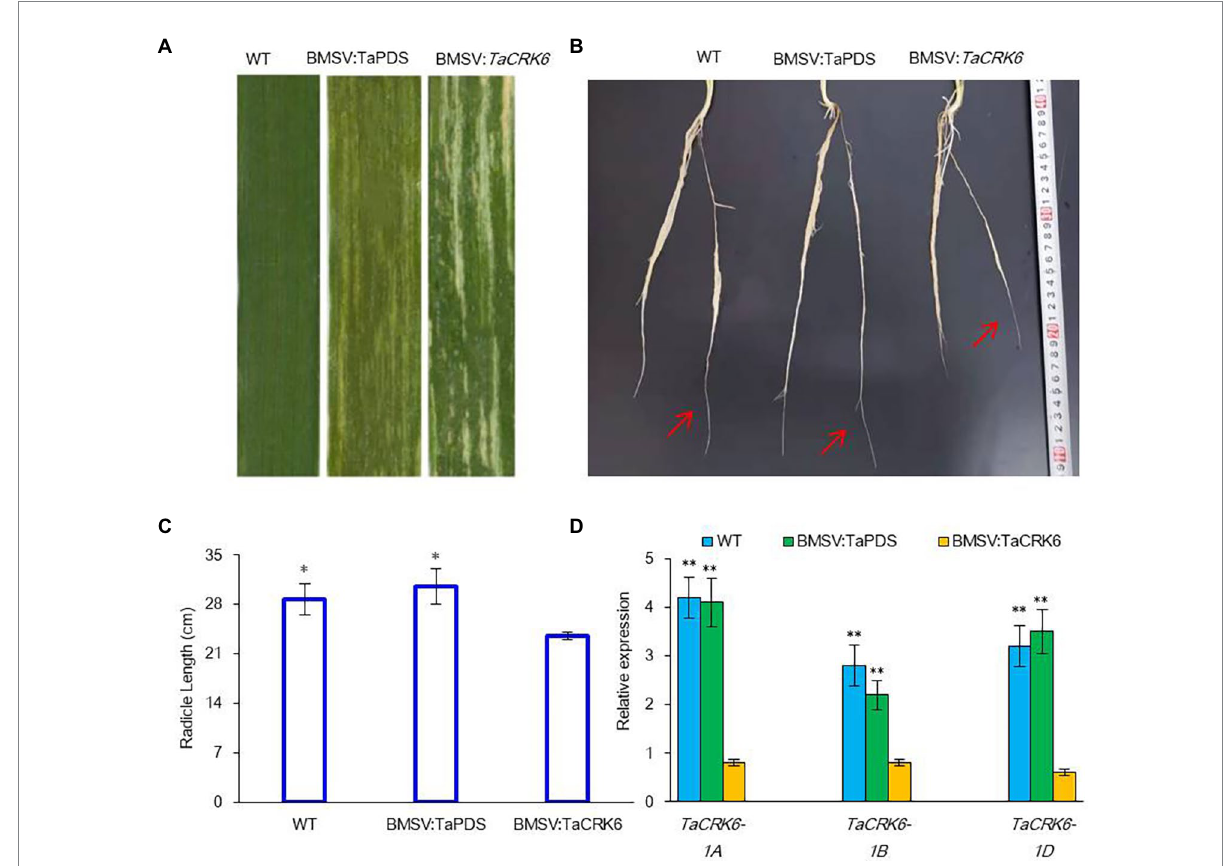
FIGURE 7 Silencing of TaCRK6 in wheat using the BSMV-VIGS system. (A) BSMV and photobleaching were evident in plants infected by BSMV:PDS after 20 days post-inoculation, (B) Radicle length at the third-fourth leaf stage with BSMV:PDS, BSMV: TaCRK6 , or BSMV:WT at 20 days post-inoculation. Red arrows indicate radicle, (C) Average radicle length of different treatments after sowing 30-days, (D) Relative transcript levels of TaCRK6 in knock-down plants and control wheat roots. The values of root are the mean ± SD from four samples, and significant differences are indicated as p < 0.05 ( * ) and p < 0.01 ( **